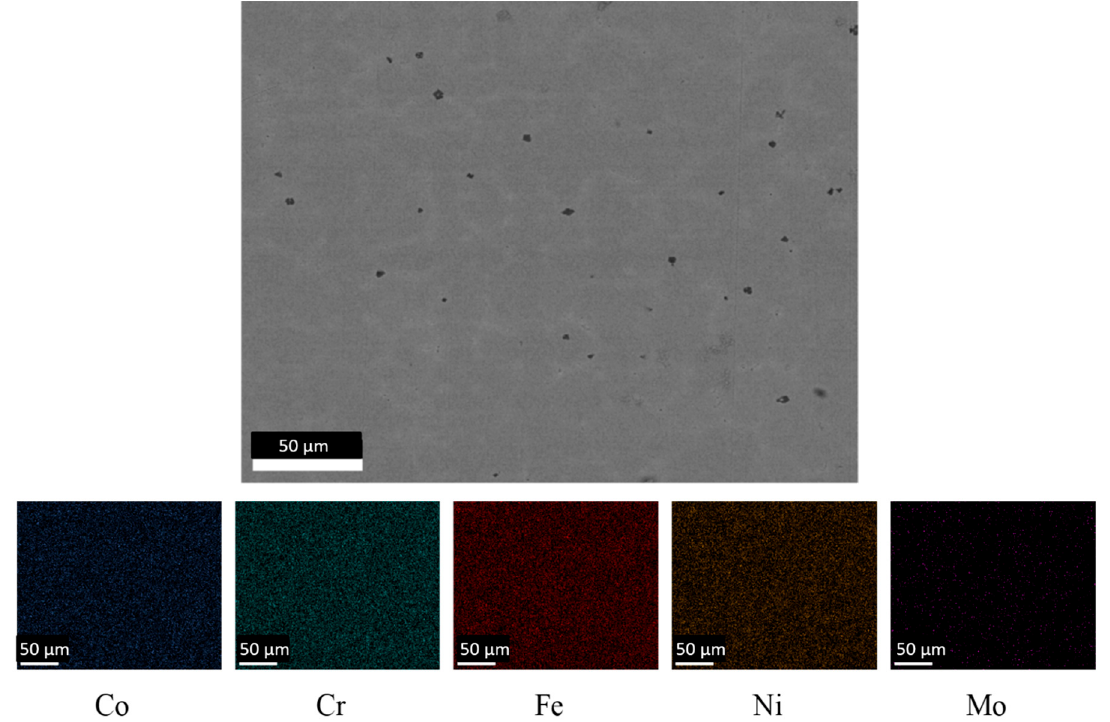
Figure 2. Scanning electron microscopy (SEM) image and EDS maps of the as-cast CoCrFeNiMo bulk material.